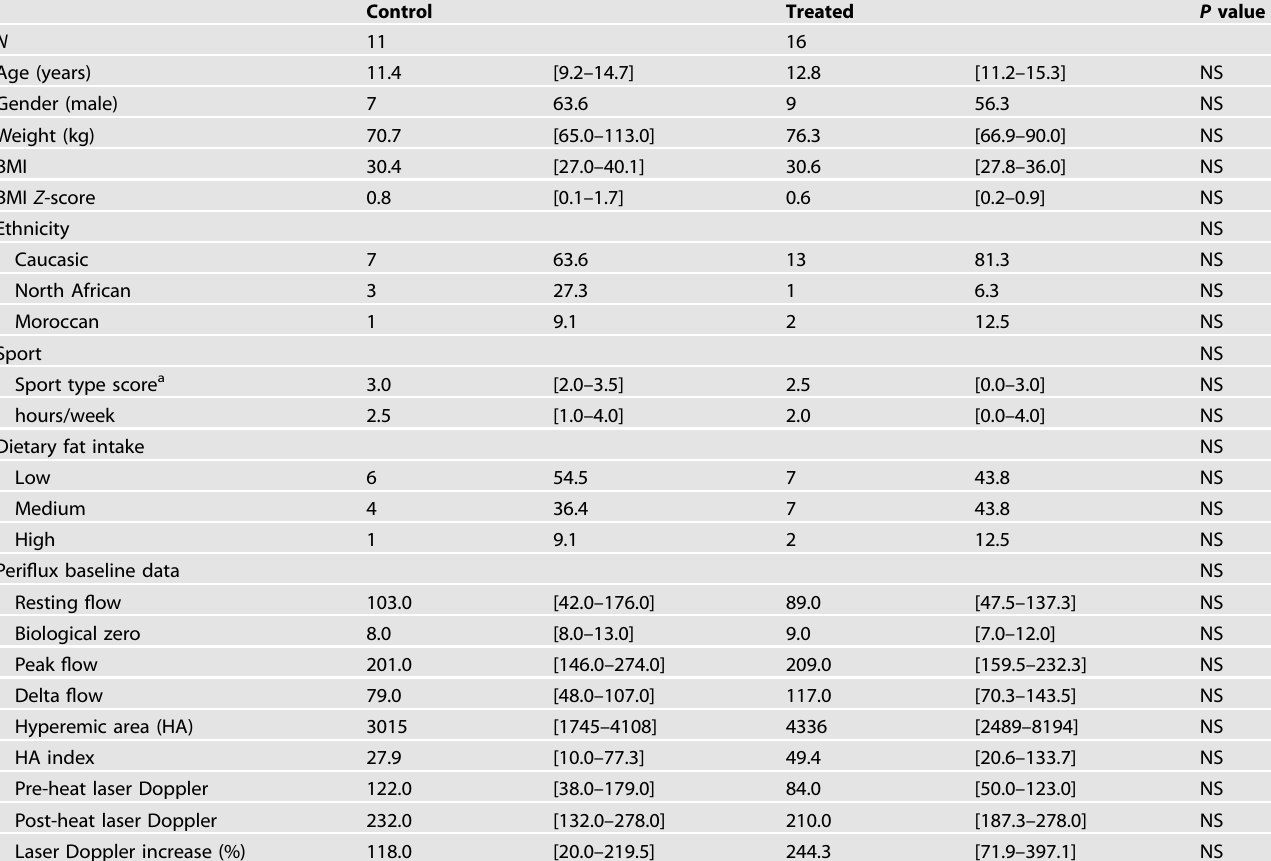
Table 2. Characteristics of completers: Placebo vs Treatment